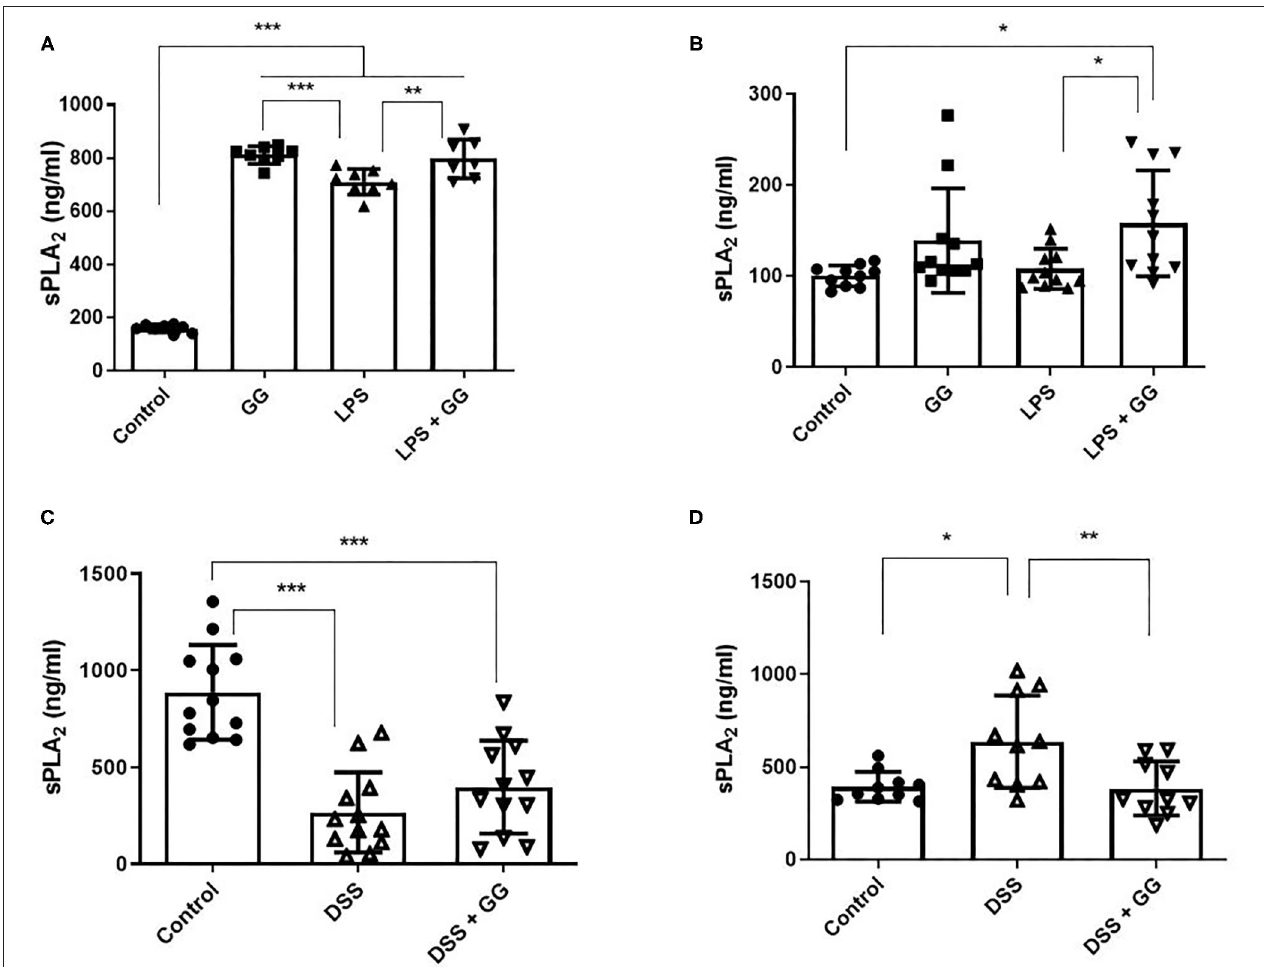
FIGURE 3 | Secretory PLA 2 activity was decreased by ganglioside at the basolateral membrane. CaCo-2 cells were grown on transwell inserts and incubated with ganglioside (10 µ g/ml) for 48h prior to exposure with inflammatory stimuli. (A,C) Illustrate the content of sPLA 2 in apical medium and (B,D) illustrate the content of sPLA 2 in basolateral medium ( N = 8 biological replicates in cell culture wells per group; N = 3 technical instrument reader replicates). The mean ± SD is illustrated. Asterisks denote statistical significance at * p < 0.05, ** p < 0.01, *** p < 0.001. GG, ganglioside.